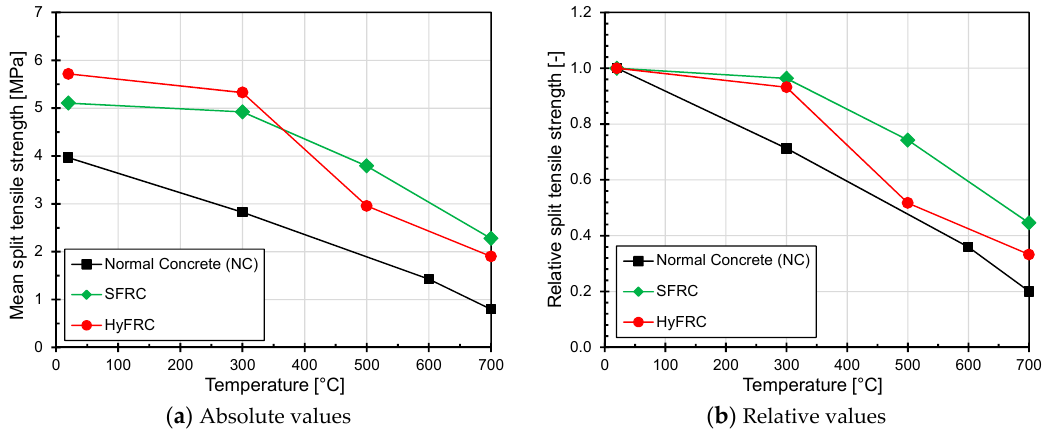
Figure 7. Influence of elevated temperature on split tensile strength of different types of concrete.